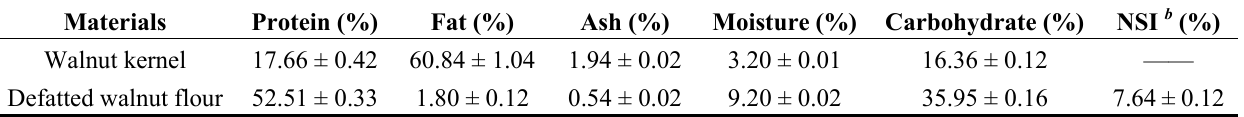
Table 1. Chemical compositions of walnut kernel and defatted walnut flour a .